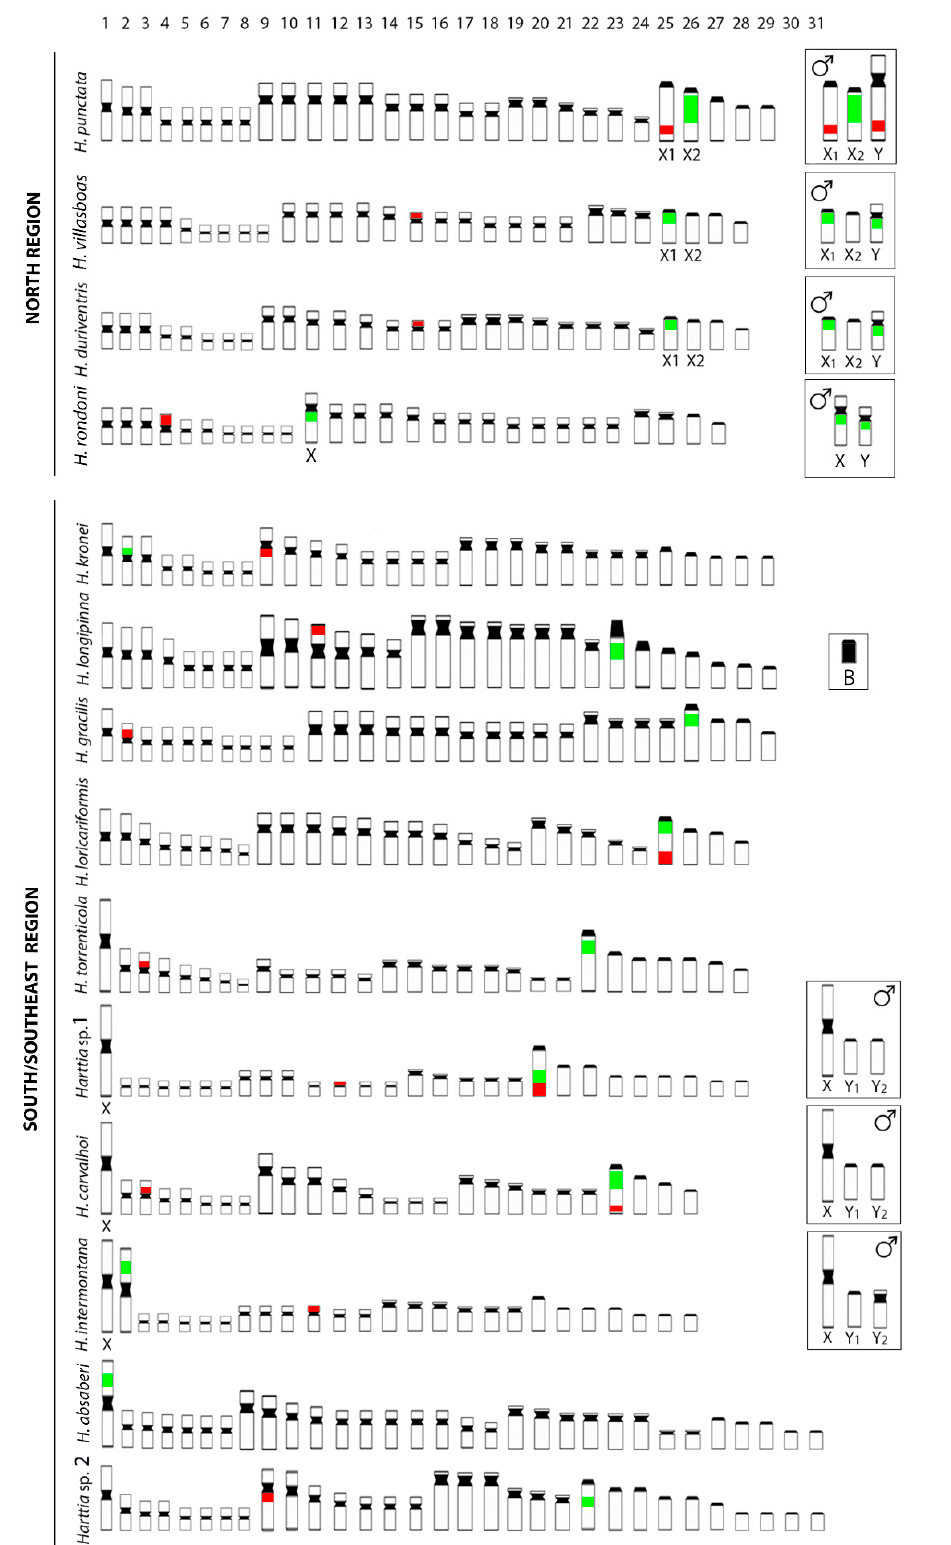
Figure 6. Representative idiograms of Harttia species from distinct Brazilian regions based on the distribution of rDNA sequences in their karyotypes, according to the present study, Blanco et al. [8], and Sassi et al. [11] data. The location of the 18S and 5S rDNA sites on the chromosomes are indicated in green and red, respectively. Inserts depict the male sex chromosomes.